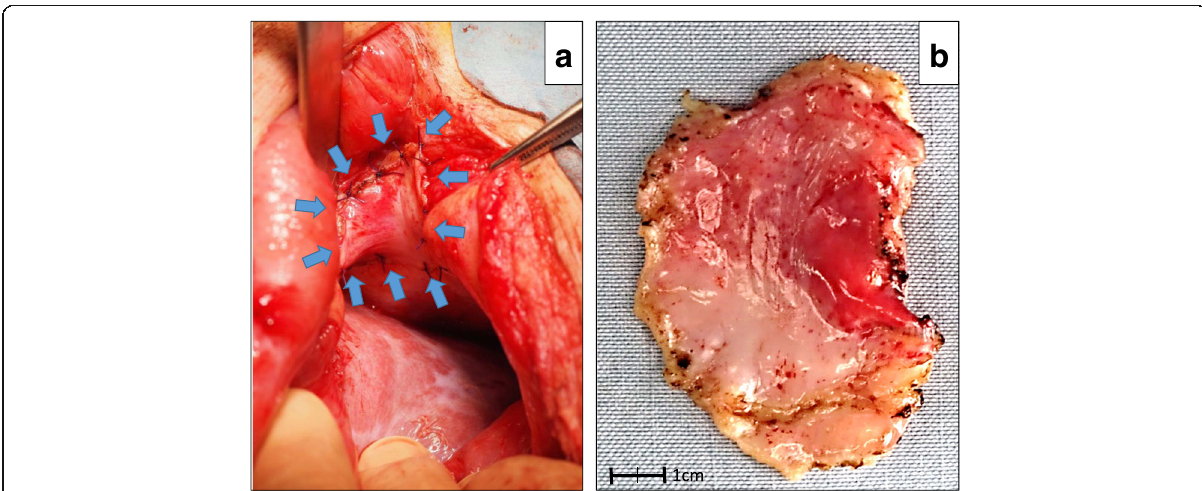
Fig. 5 a The closed diaphragmatic defect was reinforced with a graft (8 × 6 cm) of the rectus abdominis posterior sheath. b This photograph shows the 8 × 6 cm graft harvested from the rectus abdominis posterior sheath and the reinforcement with the graft